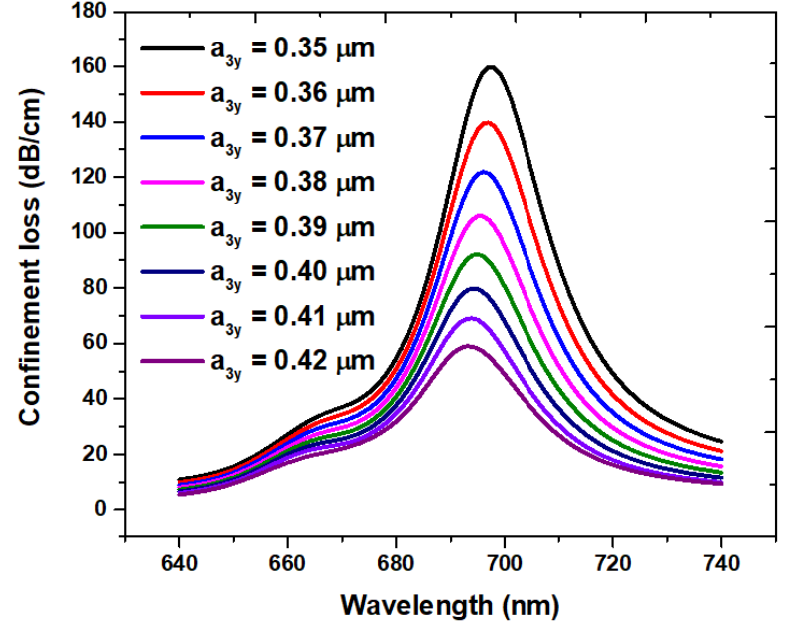
Figure 7. Confinement loss spectra of the core-guided mode for a 3 y = (0.35, 0.36, 0.37, 0.38, 0.39, 0.40, 0.41, 0.42) µm.